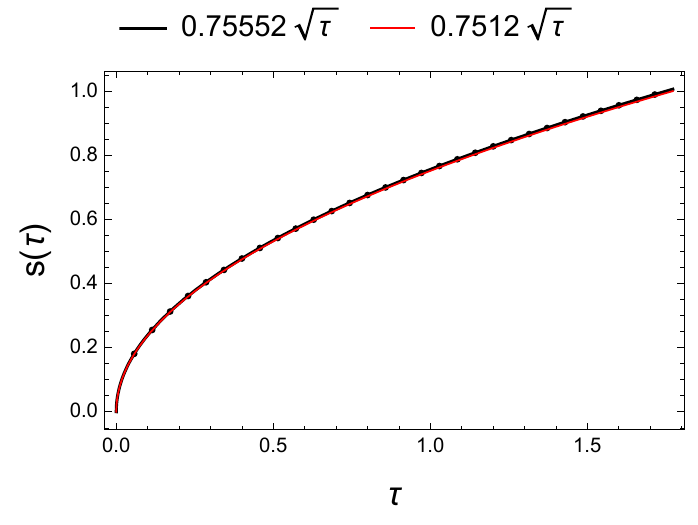
Figure 7. Numerical solution of S for α = 1, λ 1 = 1, λ 2 = 2, κ 1 = 1, κ 2 = 1.